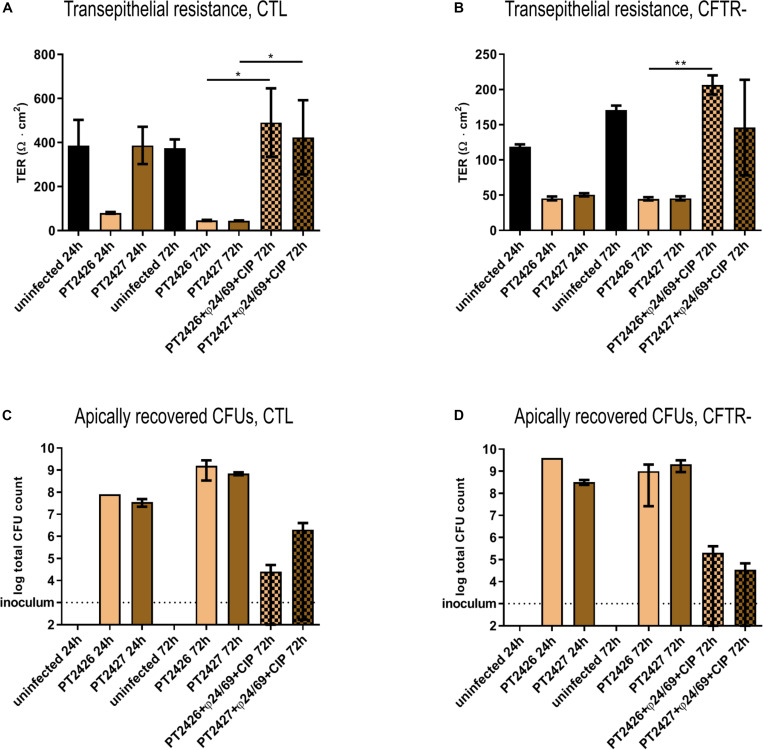
Cytotoxicity of bacteria surviving phage treatment. The cytotoxicity of PAO1-derivatives PT2426 (mucoid) and PT2527 (pyomelanin producer) were tested in absence and presence of phage cocktail/CIP treatment at 24 and 72 h p.i. on CTL (A) and cftr- cells (B). The bacterial load at the apical side of CTL (C) and cftr- cells (D) was determined by plate counting on LB-agar plates at 24 h and 72 h p.i. Values represent mean and SEM (panel A,B), and median and range (panels C,D) of three independently performed experiments. Differences in TER between the conditions were assessed using a two-tailed t-test; ∗p < 0.05, ∗∗p < 0.01.